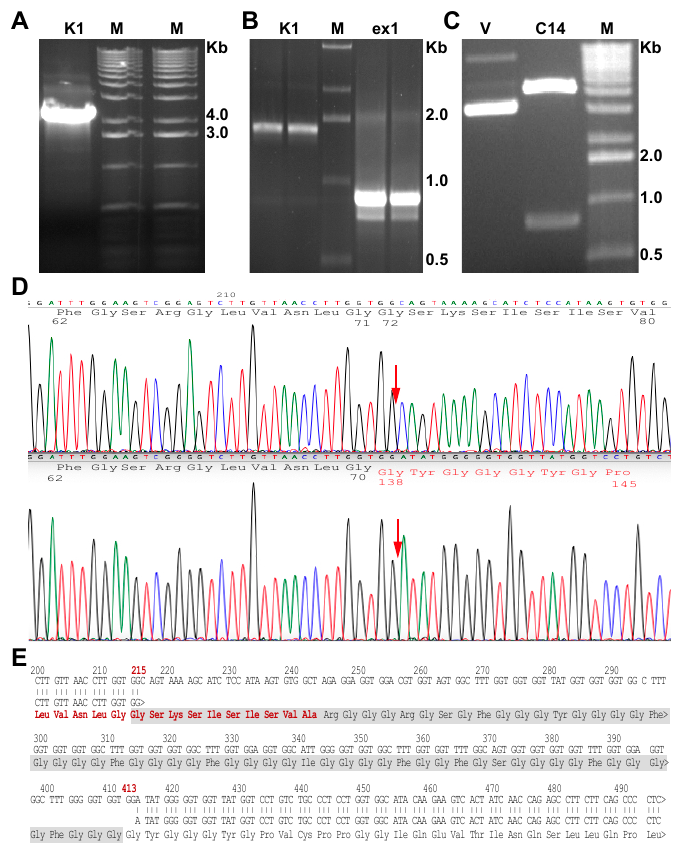
Figure 6. Molecular analysis. ( A ) Electrophoretic analysis of amplified KRT1 from genomic DNA using to sequence the gene from PBLs DNA extract. ( B ) Electrophoresis of full length KRT1 cDNA and fragment of exon 1 (right lanes), obtained from the reverse ‐ transcription and amplification using RNA extracted from palmar skin biopsy. Right lanes show specific amplification of exon 1, which are evident by the smaller band due to the presence of the deletion. ( C ) Electrophoresis of a positive clone containing the deleted K1 exon 1, the vector was digested with BstXI restriction enzyme. ( D ) Electropherograms showing the sequence of the WT and mutated K1 of the patient obtained from cloned exon1 fragments. ( E ) Sequence alignment of WT and mutated K1, showing